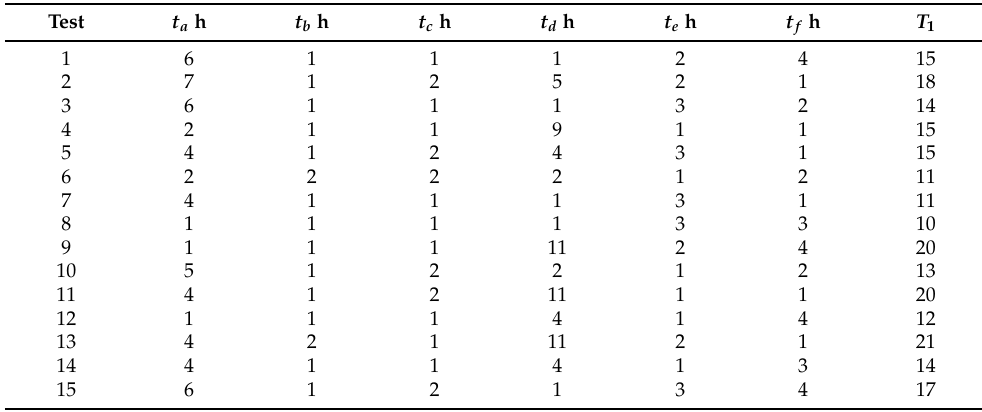
Table A1. Processing times for standard extraction method ( i =